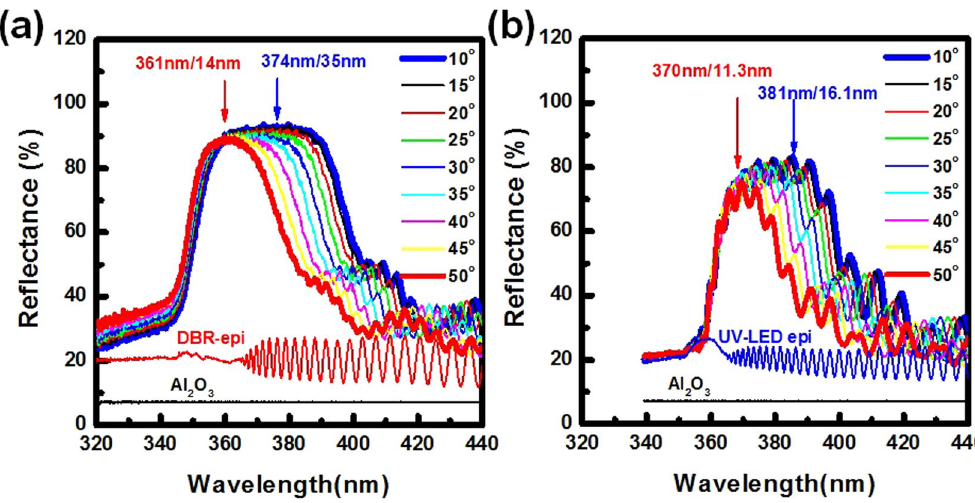
Figure 4. Angle-dependent reflectance spectra of ( a ) the porous AlGaN reflector and ( b ) the EC-UV-LED structures were measured by varying the detected angles from 10° to 50°. The central wavelength and the band- width at 10° and 50° detected angles were labeled. The reflectance spectra of the non-treated DBR epitaxial structure (DBR-epi), the non-treated UV-LED epitaxial structure (UV-LED epi), and the flat Al 2 O 3 substrate were